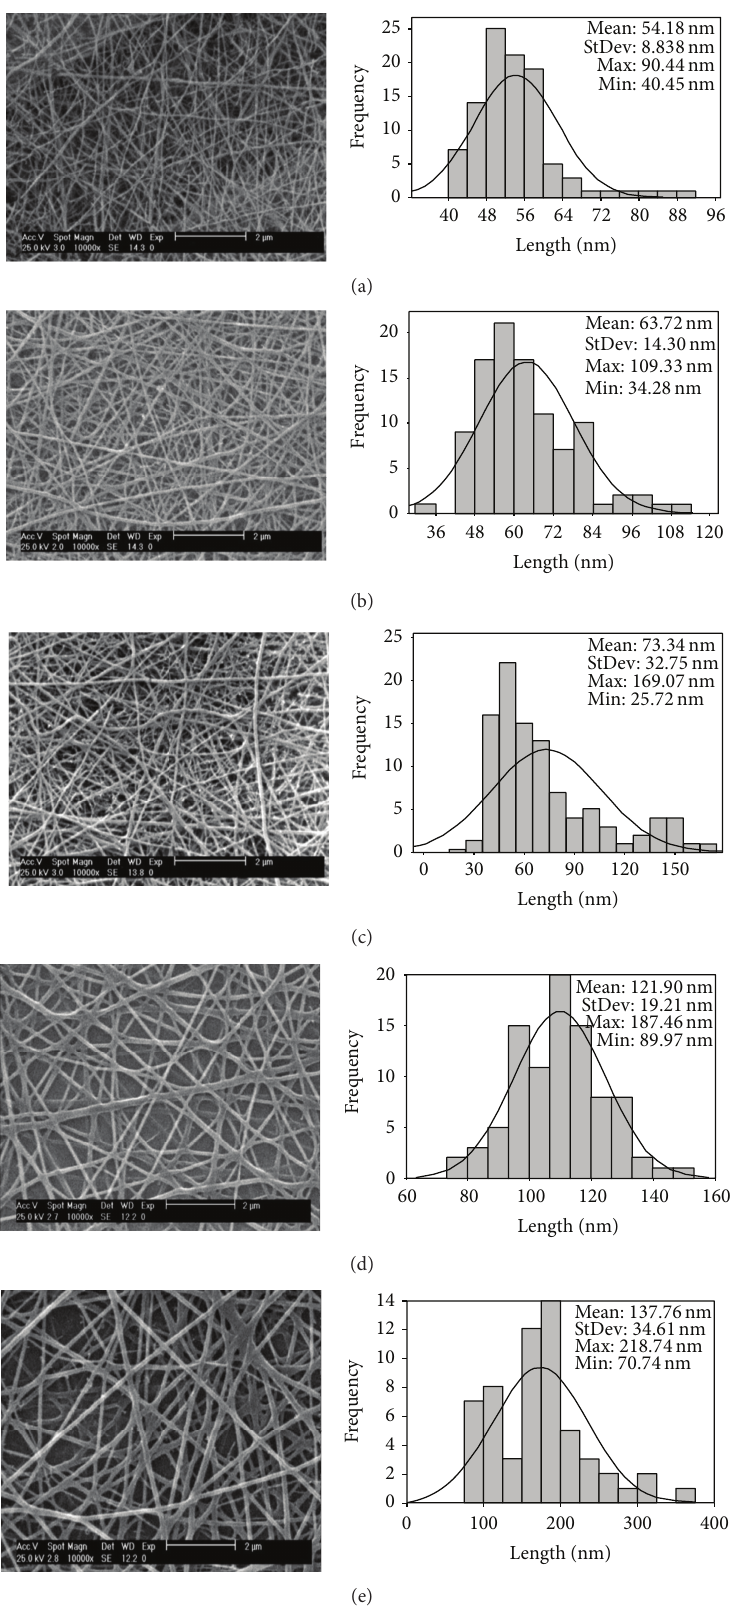
Figure 3: SEM images and diameter distribution of polyamide-6/chitosan nanofibers with different ratios: (a) 100/0, (b) 90/10, (c) 80/20, (d) 70/30, and (e)